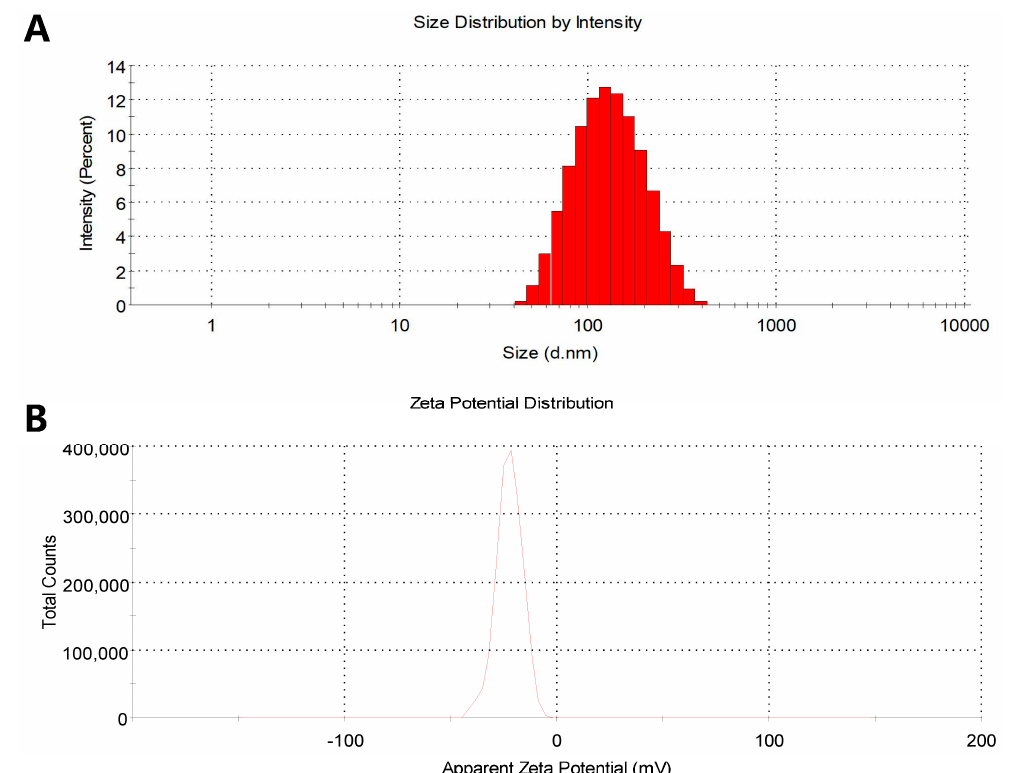
Figure 1. Characteristics of the liver-targeted baicalin liposomes (BAA1). ( A ) The particle size was measured by using the Malvern Zetasizer Nano ZS90 (Malvern Instruments Ltd., Malvern, UK). ( B ) Zeta potential was measured by using the Malvern Zetasizer Nano ZS90 (Malvern Instruments Ltd., Malvern, UK).